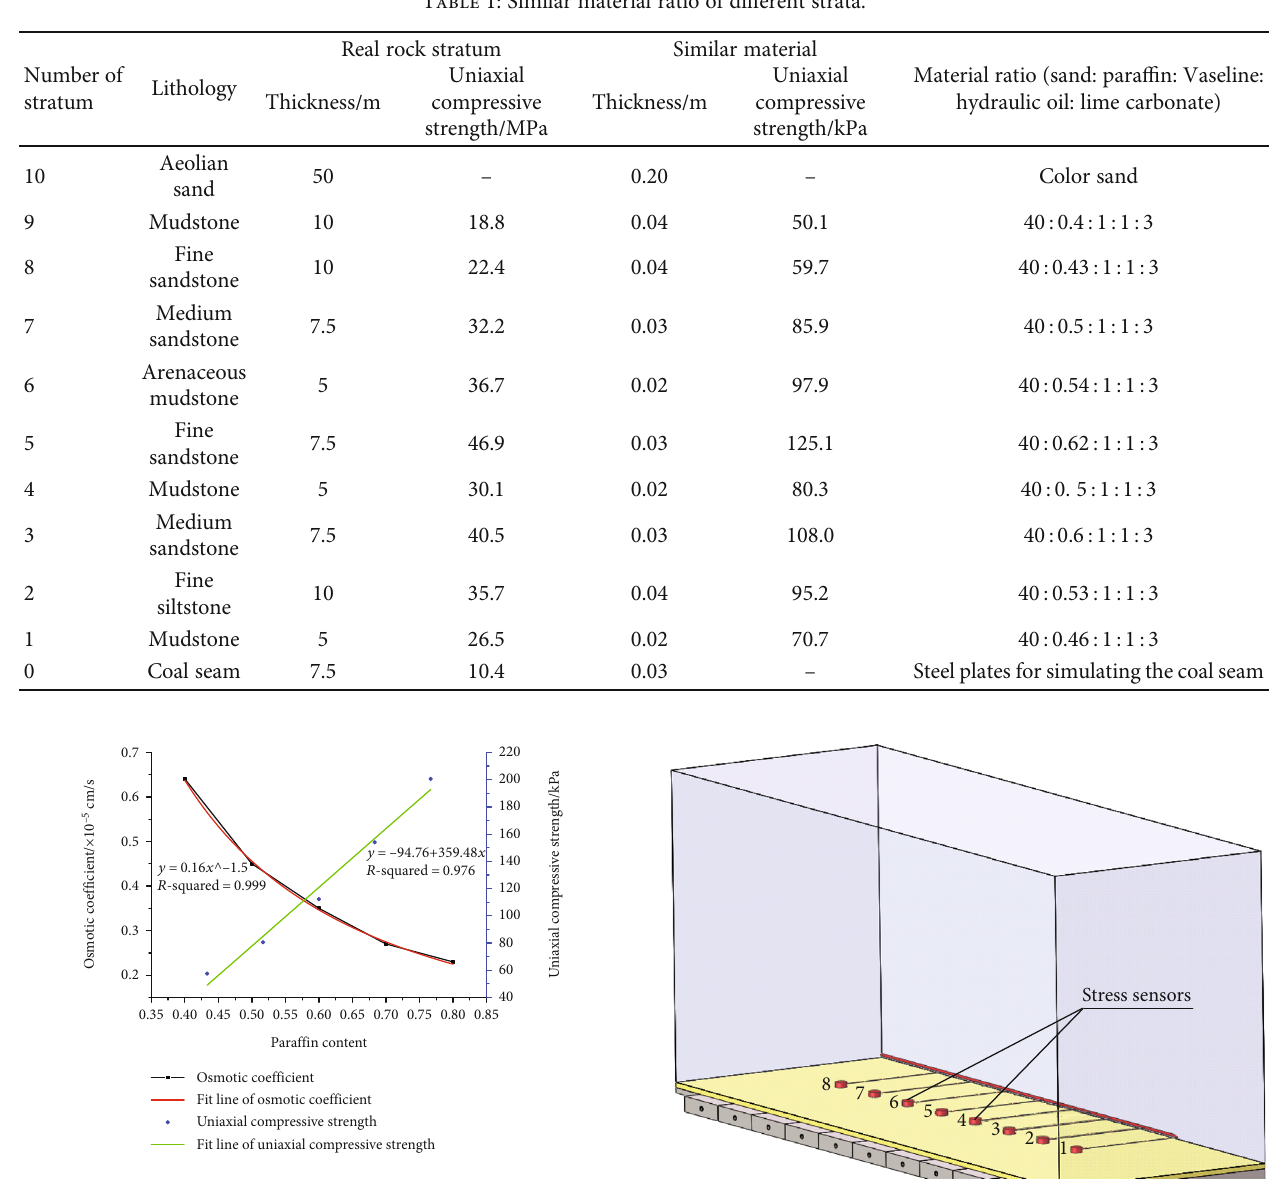
Table 1: Similar material ratio of di ff erent